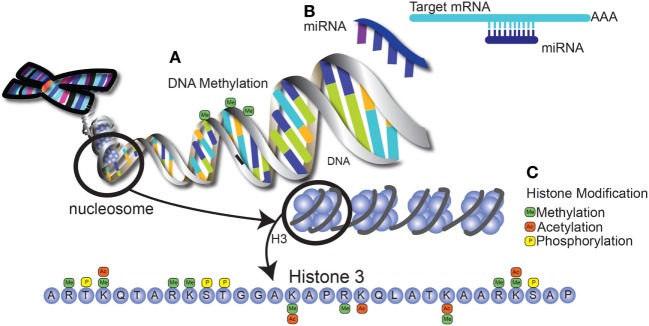
Epigenetic modification alters gene expression through multiple mechansims. (A) DNA methylation occurs at regions that are rich in cytosine and guanine (CpG islands), leading to the repression of gene transcription. (B) MicroRNAs are short, non-coding RNA molecules encoded in the genome that bind to mRNA, leading to mRNA degradation or translational suppression. These matches can either be fully complementary or may contain mismatched bases, allowing one miRNA to target several mRNA molecules. (C) Histone modifications include methylation and acetylation of lysine and arginine residues on histone tails, as well as phosphorylation of serine and threonine residues. Potential modifications of the tail of histone 3 are shown as an example. These modifications result in changes in chromatin structure that can be either repressive or permissive for transcription factor binding.